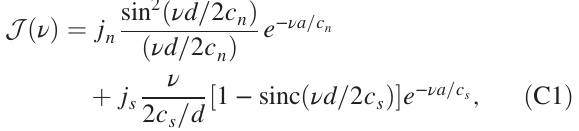
FIG. 7. G plotted as a function of V dc 0 . 8 meV. The plot features strong oscillations parallel eV ac ¼ to the interdot charge transition